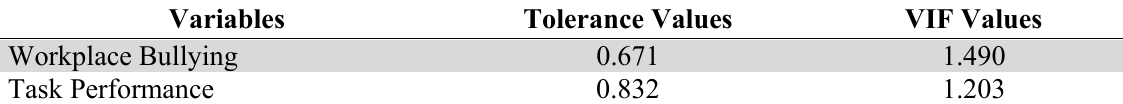
Cross-Validated Redundancy for the Endogenous Variable Endogenous Variable Occupational